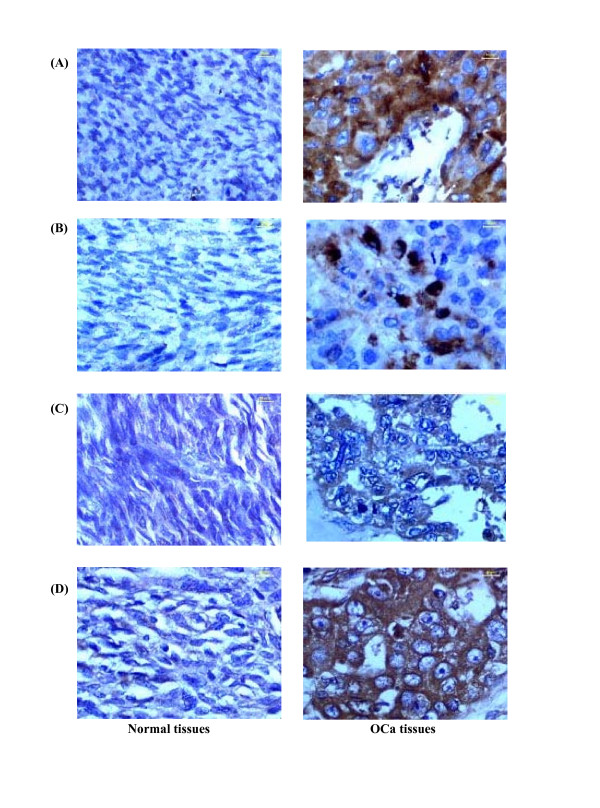
Immunohistochemical analysis of protein expression in ovarian tissues of normal donors and ovarian carcinoma patients. Immunohistochemical staining was performed using antisera to (A) CPL, (B) CLU, (C) ACT, and (D) AAT. Panels A and B demonstrate immunohistochemical stains showing strong positive CPL and CLU expression in ovarian cancer (OCa) tissues but negative expression in normal ovarian tissues (internal positive control). Panels C and D demonstrate immunohistochemical stains showing moderate positive ACT and strong positive AAT expression in OCa tissues, respectively, but weak positive expression in normal ovarian tissues.